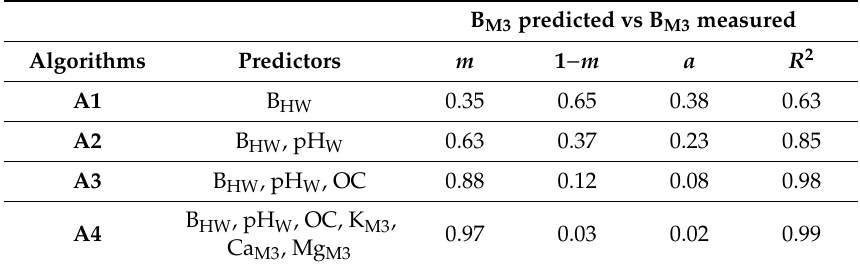
Figure 2. ( a ) Linear regression between measured boron extracted by hot water (B HW ) and measured boron extracted by the Mehlich-3 solution (B M3 ); ( b ) Linear regression between measured B M3 and predicted B M3 (by the linear model of Figure 2a). Table 4. B M3 prediction results by four AutoML (Automatic Machine Learnig)